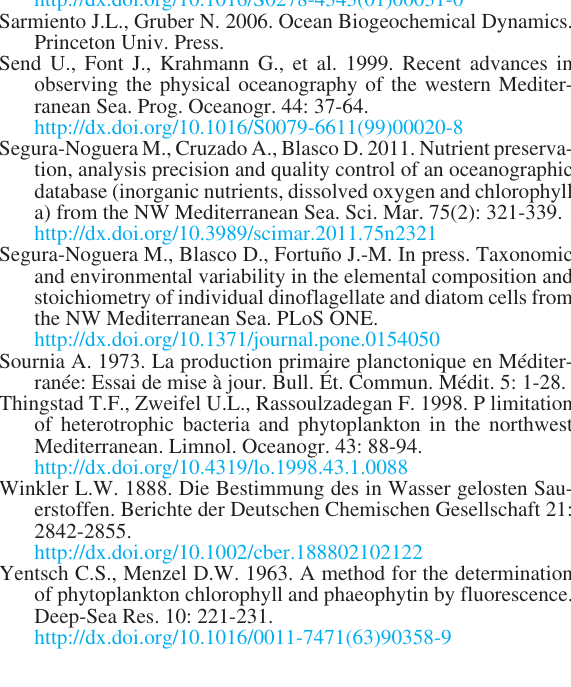
Table S9. – Salinity with depth and stratification of the water column in the Catalan Sea (NW Mediterranean Sea). Shown are average ± standard deviation (number of data between parentheses). SL, Standard Level; SLD, Standard Level Depth (m). Fig. S1. – Position of oceanographic stations in the Catalan Sea with phosphate, nitrate, nitrite, ammonium, silicate, dissolved oxygen and chlorophyll a data. Isobaths correspond to 100, 200, 400, 1000, 2000 and 2500 m